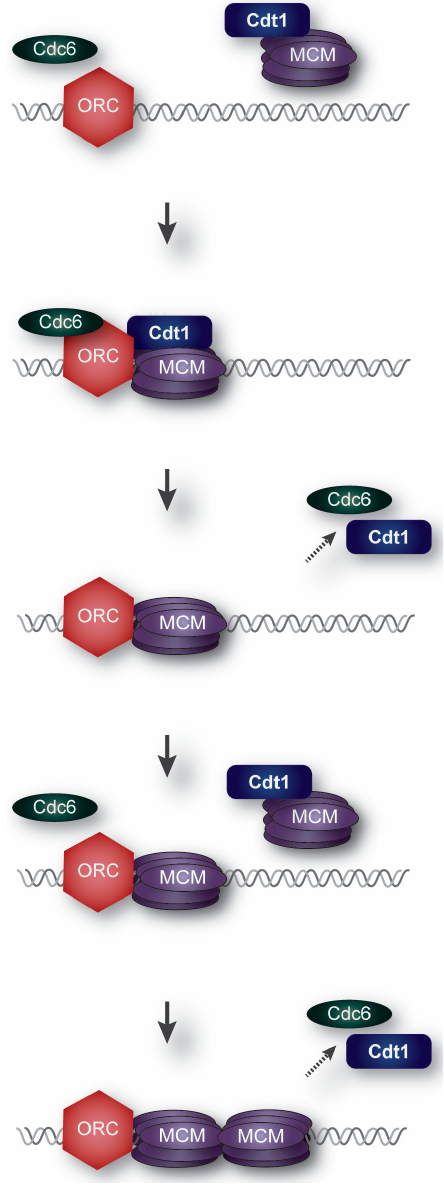
Figure 1. Origin Licensing. Minichromosome Maintenance (MCM) hexamers are loaded by Cdt1, Cdc6, and Origin Recognition Complex (ORC) at presumptive chromosomal origins during G1 phase.